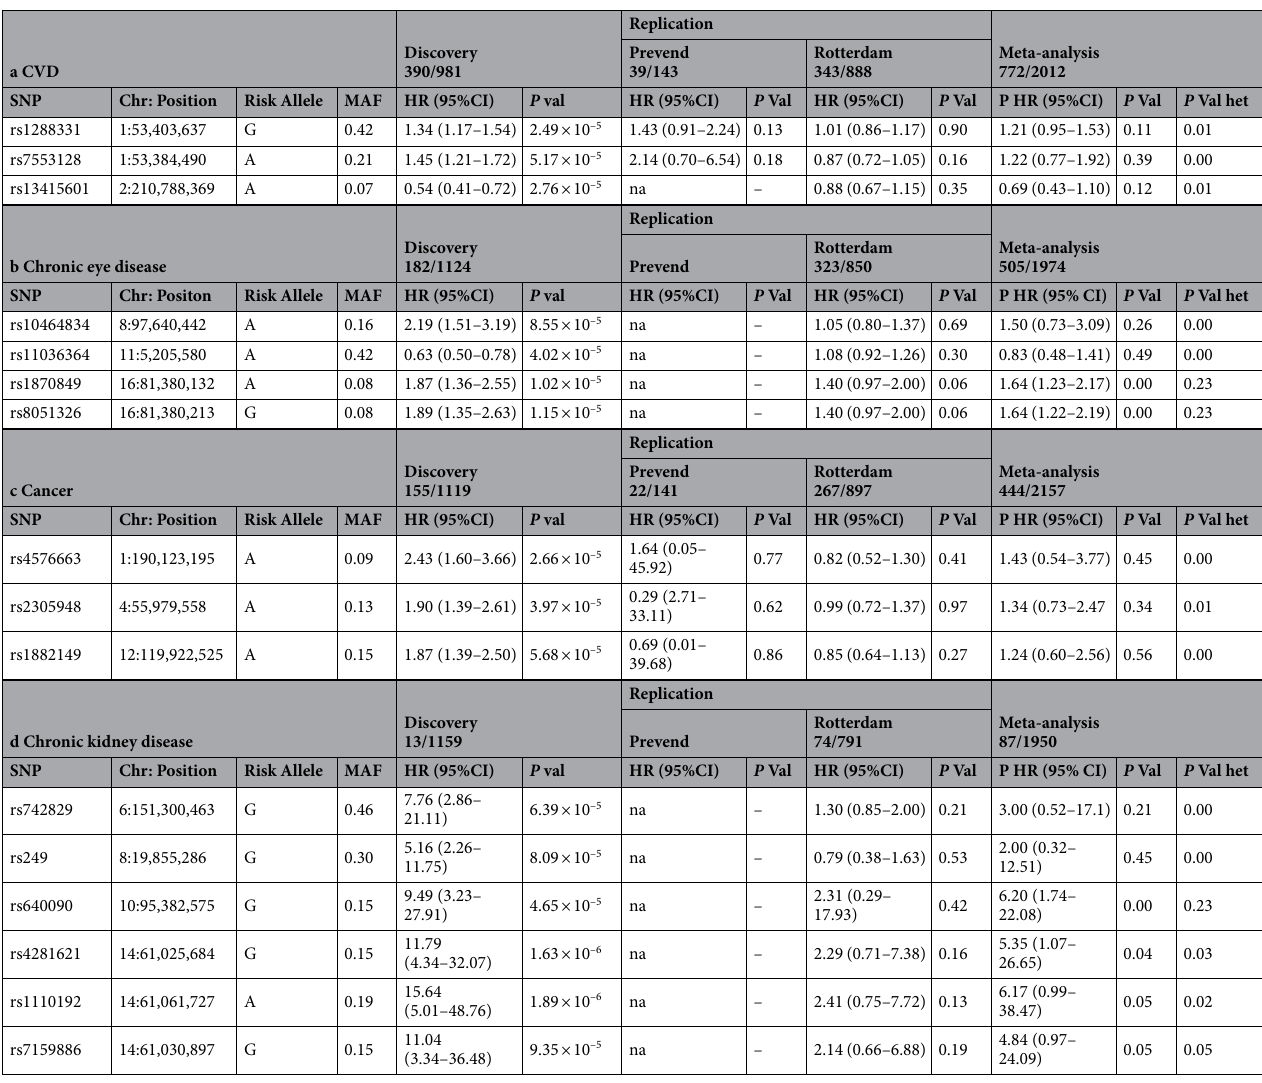
Table 3. Meta-analysis of cohorts for the association of suggestive SNPs with the comorbid disease in T2D